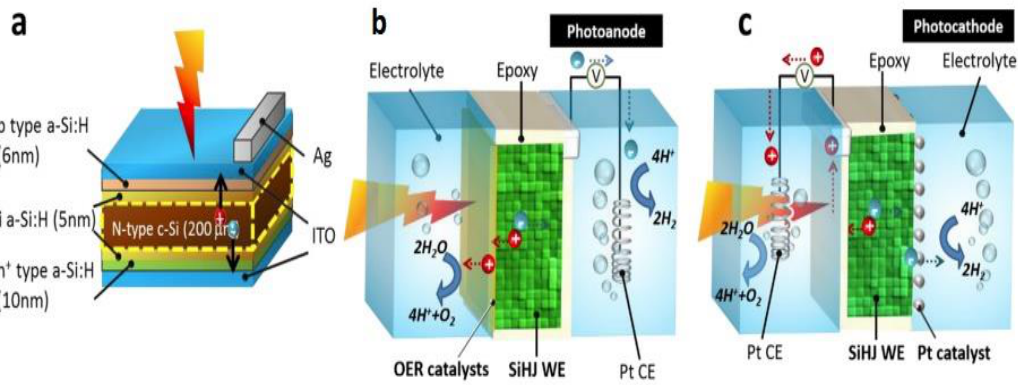
Figure 10. This is a figure data presented from [76]. ( a ) Schematic of the SiHJ solar cell and ( b ) schematic of the SiHJ photoanode; ( c ) schematic of the SiHJ photocathode. Study [77] suggests a practical way to improve the photoresponse of Si-based planar photocathodes based on the creation of a Si junction. Here, a soft and feasible strategy for fabricating an amorphous Si/crystalline Si (a-Si/c-Si) junction photocathode with a Pt co- catalyst is proposed. The a-Si layer acts as an electron transfer agent to form a deep a-Si/c-Si junction with a large energy band shift, thereby allowing easy charge transfer. Meanwhile, the a-Si layer serves as a growth substrate to obtain controllable Pt nanoparticles. The Pt/a-Si/c-Si photocathode demonstrates an onset potential of 0.42 V. The photocurrent up to − 35.0 mA cm − 2 was obtained on Pt/a-Si/c-Si, which is much higher than without the a-Si